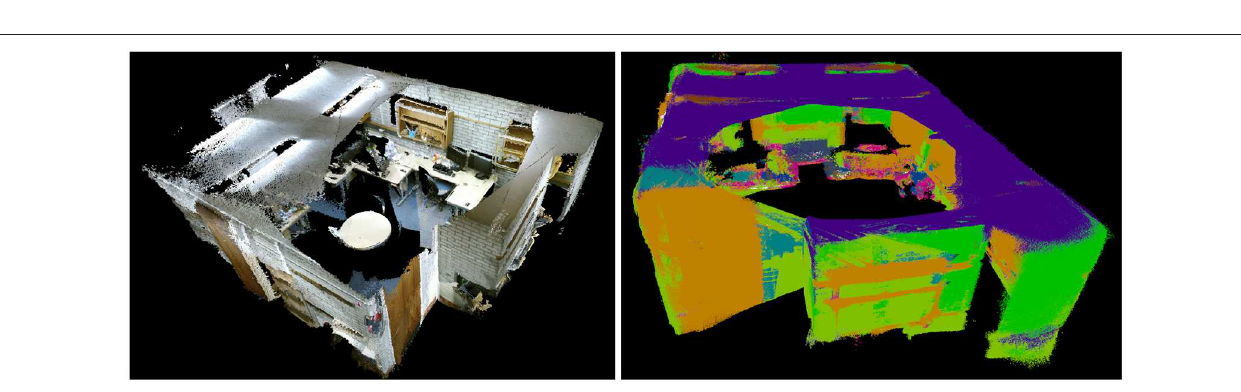
FIGURE 8 | Material segmentation and reconstruction in an industrial scenario. (Left) Global 3D map. (Right) Global 3D semantic